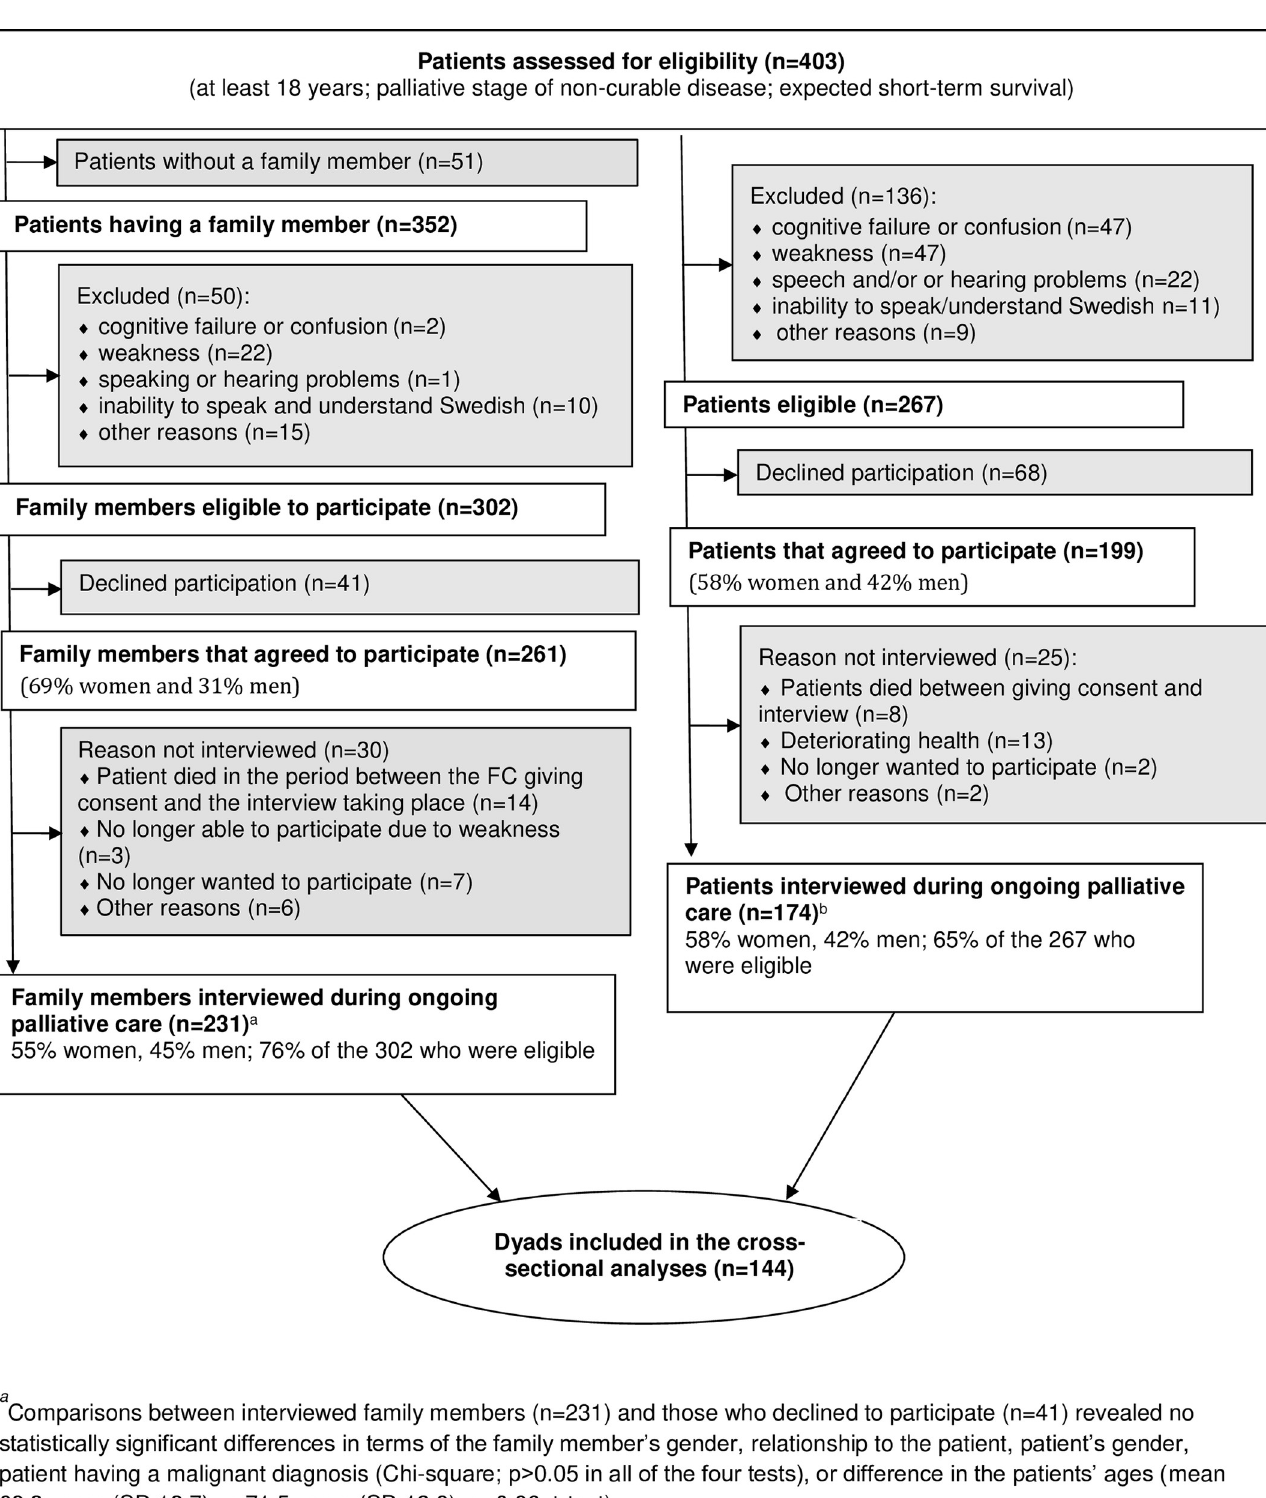
Fig 1. Flow diagram. https://doi.org/10.1371/journal.pone.0257274.g001 PLOS ONE | https://doi.org/10.1371/journal.pone.0257274 September 14,